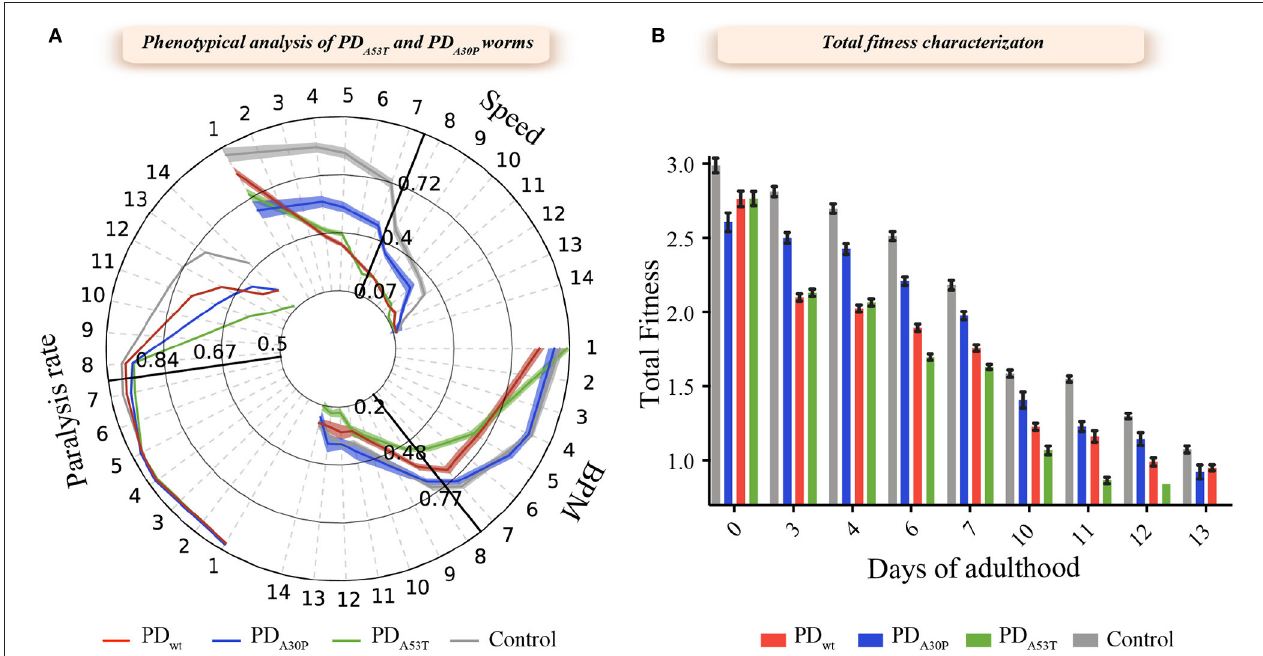
FIGURE 1 | Behavioral characterization of the PD A30P and PD A53T worm strains. (A) Three common readouts of worm fitness were investigated for each strain using an automated worm tracking procedure ( Perni et al., 2017b). The results are presented with a behavioral time-course map of PD A30P and PD A53T worms over 14 days of adulthood. The speed of movement, number of body bends per minute (BPMs), and the rate of paralysis were followed during aging; data are normalized with respect to day 1 to illustrate the progressive decline in all readouts. PD worms overexpressing wild-type α -syn:YFP in the body-wall muscle cells (PD WT ) were used as a positive control, while worms expressing only YFP were used as negative healthy controls (Control). Shadowed areas represent standard errors of the mean (SEM). (B) The rate of body bends, speed and paralysis rate were combined into a single score of total fitness and evaluated during the duration of the experiment. For each experiment, about 1,000 worms were analyzed and each experiment was carried out in triplicate; one representative experiment of three experiments is shown. At each time point, the mutant worms exhibited lower fitness ( p < 0.0005) when compared to healthy worms; error bars represent the standard error of the mean (SEM); the statistical significance was assessed using the 2-way ANOVA method with Dunnett’s multiple comparison